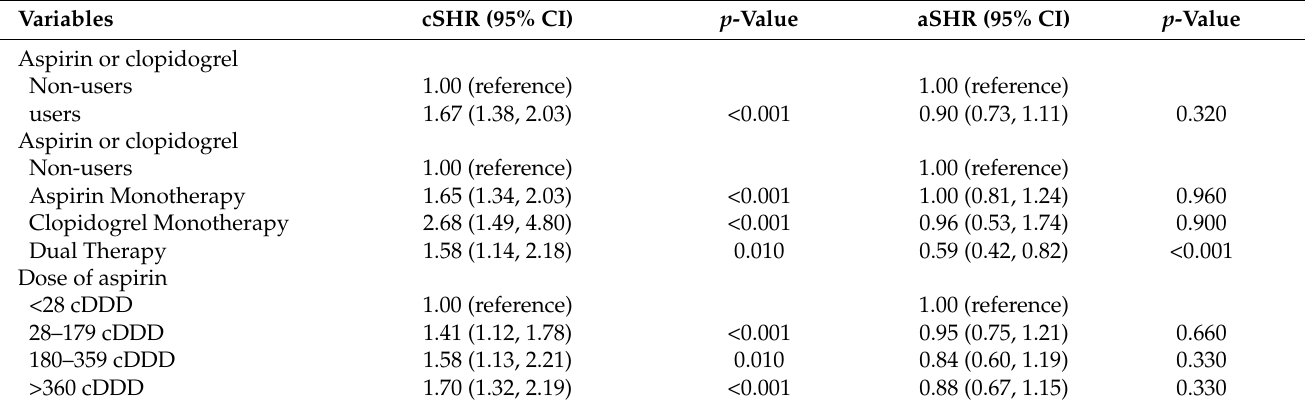
Table 4. Incidence rate and subhazard ratio of hip fracture in patients using antiplatelet agents employing competing risks regression